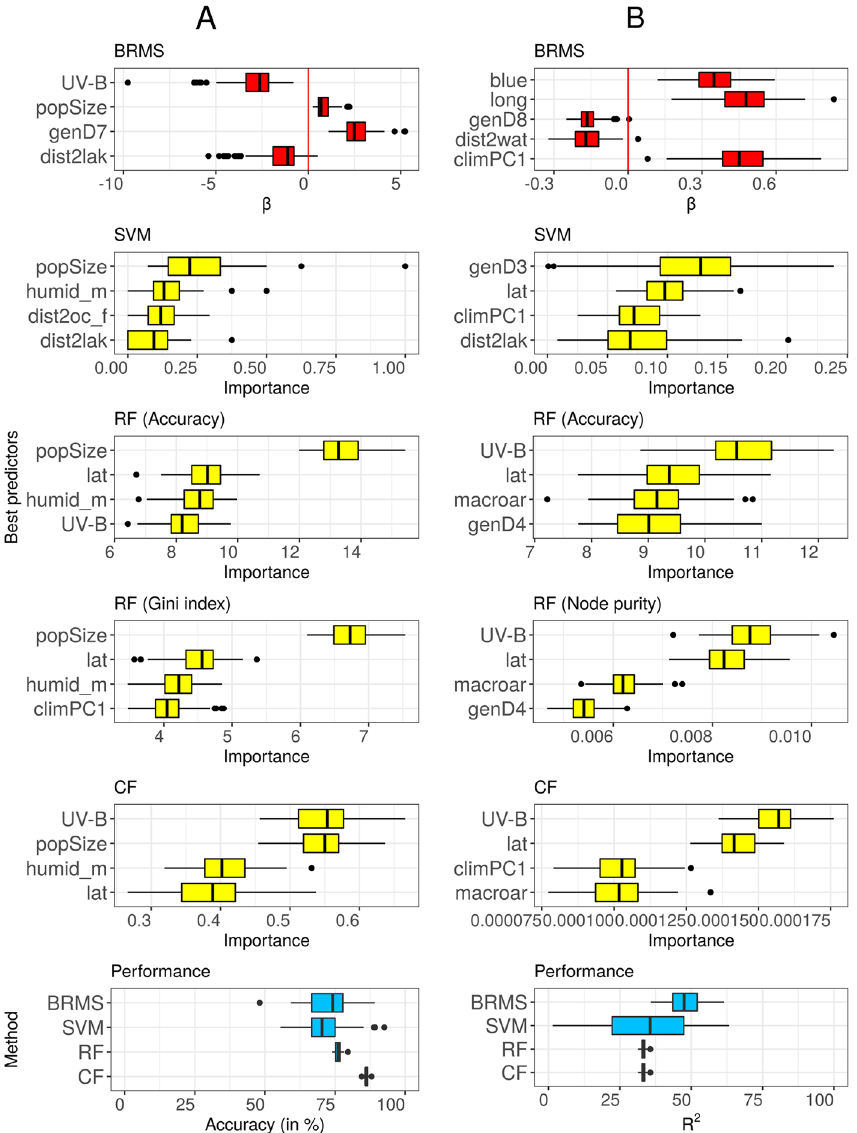
Figure 3. Predicting the existence of a dedicated word for blue (Panel A , left) and frequency of abnormal red-green color perception (Panel B , right); only the 7 best predictors are presented here (see Methods). 1st row: Using Bayesian mixed-effect models (BRMS), the best predictors’ (according to Bayes Factor, WAIC, LOO and K-Fold methods) slope estimates. 2nd row: specificity-based predictor importance from SVMs. 3rd row: accuracy-based predictor importance from random forests (RF), measuring the amount by which the accuracy decreases when one variable is removed from the model; higher values represent more important predictors. 4th row: Gini-index-based predictor importance from random forests (RF); this measures by how much the Gini impurity decreases when a variable is chosen to split a node (note, only relative values matter, and there is a bias towards using numeric variables to split nodes). 5th row: unconditional predictor importance from conditional random forests (CF); this is similar to the accuracy-based importance from random forests. 6th row: the performance of the four methods (BRMS, SVM, RF and CF) in terms of accuracy (left; as this is a binary classification problem) and R 2 (right; as this is a regression problem). Variable names have been abbreviated for legibility: popSize is population size, humid_m is median humidity, dist2lak is the distance to the closest lake, lat is latitude, genD4 is the 4th dimension of the multidimensional scaling of the between-populations genetic distances, climPC1 is the 1st principal component resulting from the Principal Component Analysis (PCA) of the climate variables, macroar is the macroarea, long is the longitude, and dist2wat is the distance to the closest body of water (ocean/sea, lake or river). Plots generated using R 59